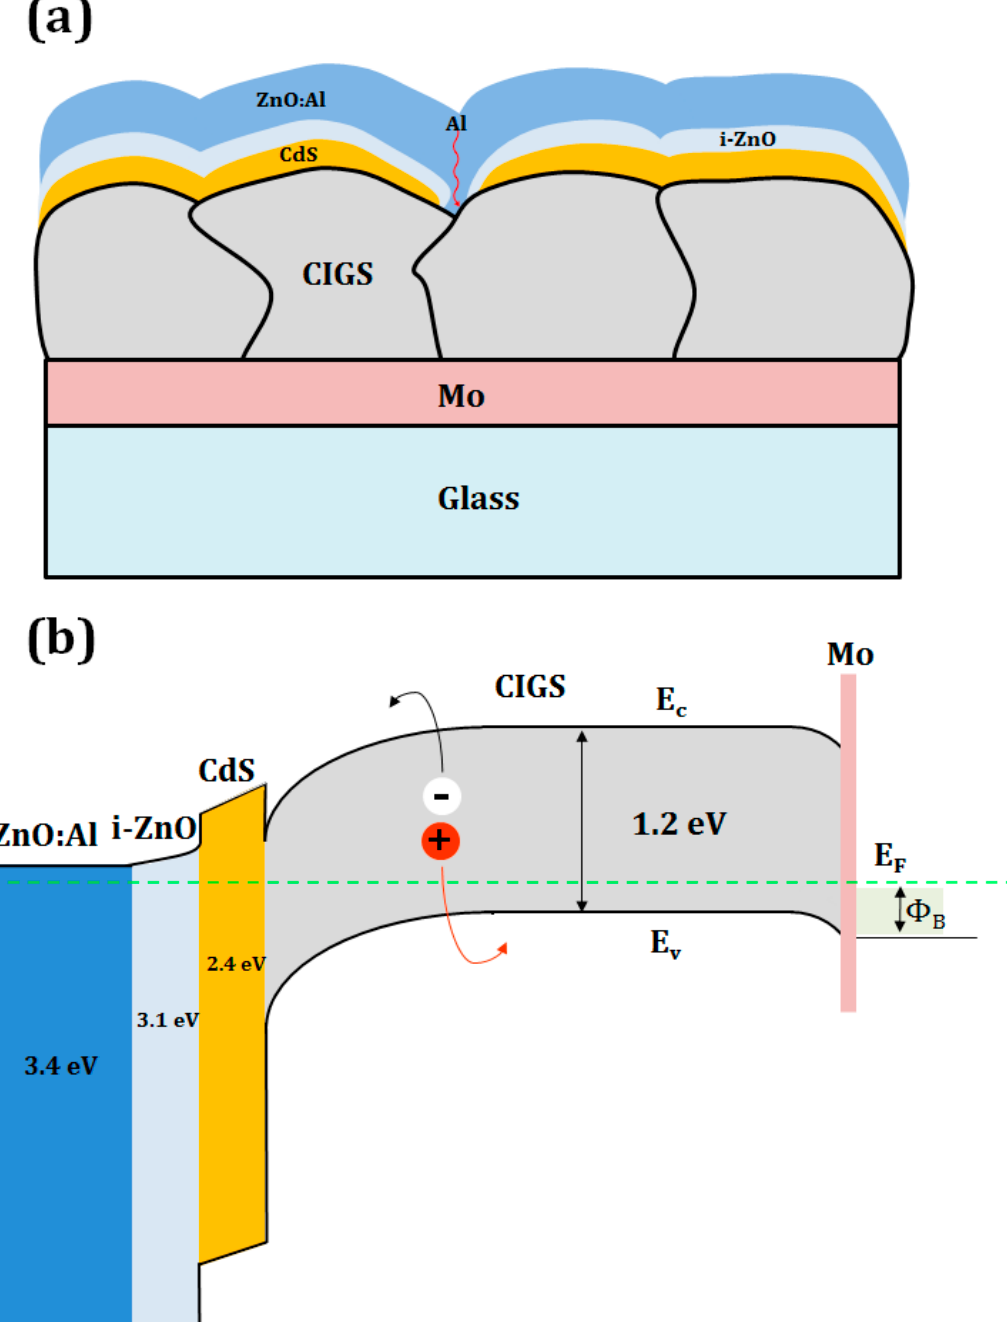
Figure 1. Schematic of ( a ) typical structure and ( b ) energy band diagram of CIGS device. (Modified from Reference [19]). Table 1. Summary of the i-ZnO thickness for different CIGS processes by several research groups and companies .